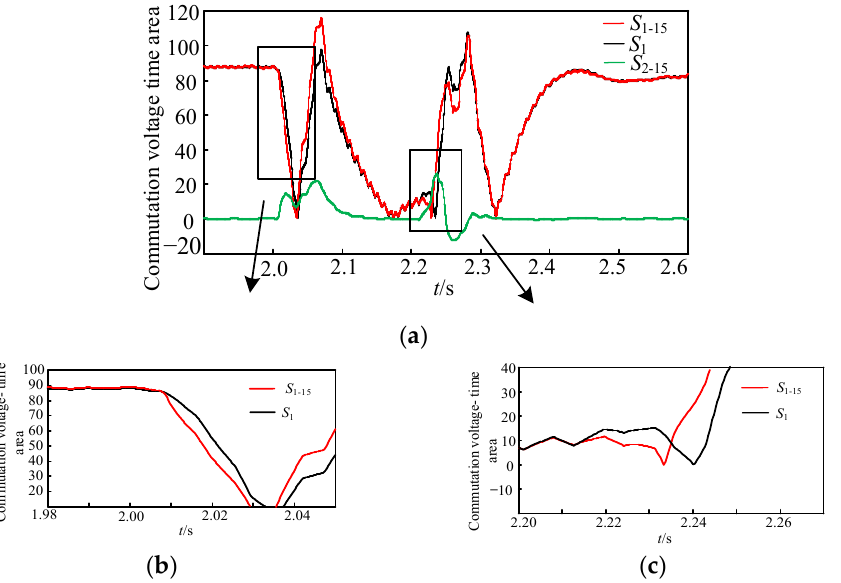
Figure 6. Commutation voltage time area after commutation bus fault. ( a ) Commutation voltage time area of the whole simulation. ( b ) Commutation voltage time area before the first commutation failure. ( c ) Commutation voltage time area before the subsequent commutation failure.